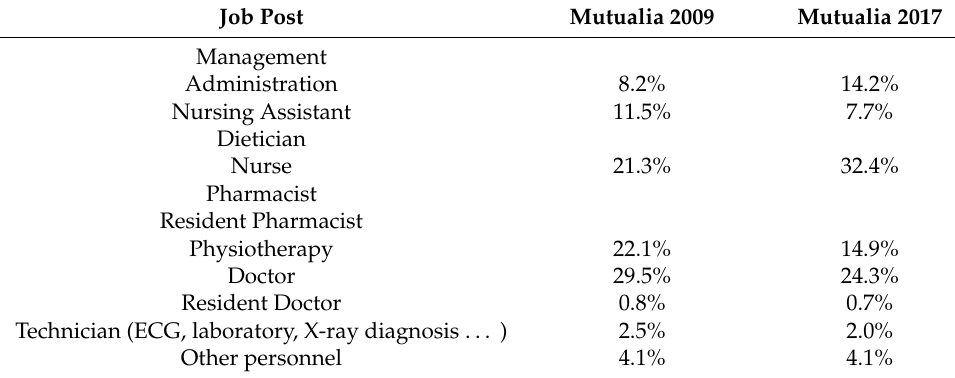
Table 3. Distribution by current job post of the personnel who responded to the survey at Mutualia (2009 and 2017).